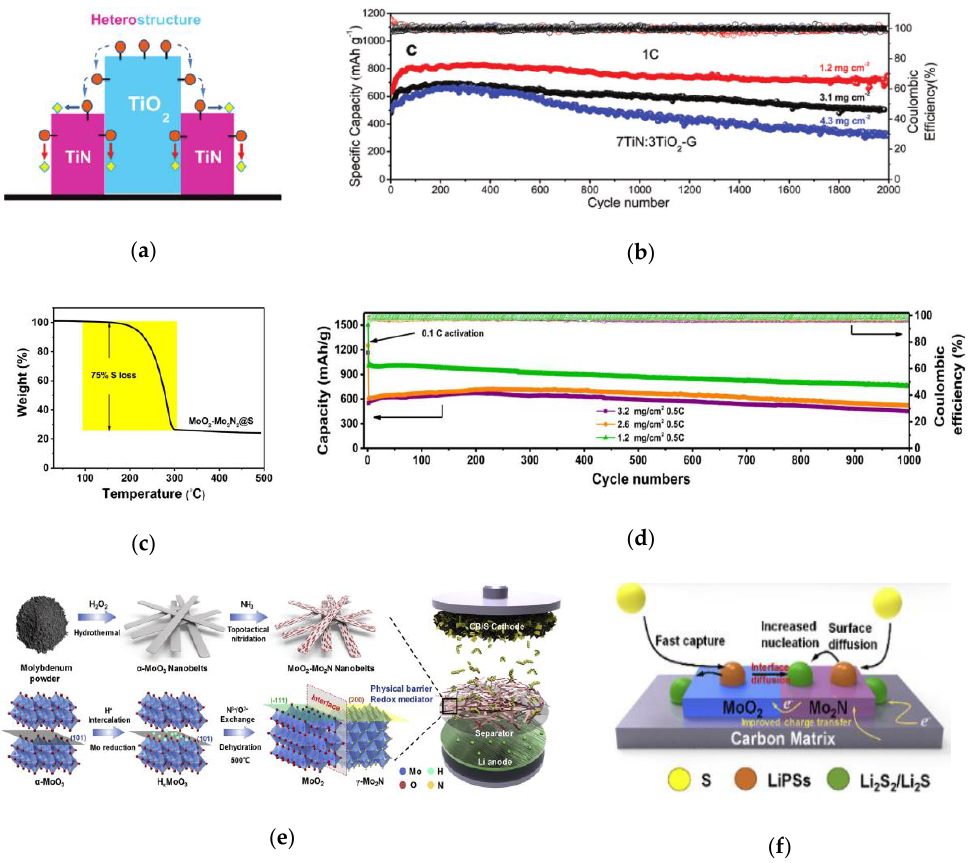
Figure 7. ( a ) The TiO 2 –TiN heterostructure surface [54] . ( b ) Ultra-long cycling for the optimal cells with the 7TiN:3TiO 2 –G coating layer at 1 C for about 2000 cycles with different sulfur loadings of 1.2, 3.1, and 4.3 mg cm −2 [54] . ( c ) TG measurement curve of MoO 2 −Mo 3 N 2 @S composite [56] . ( d ) Discharge